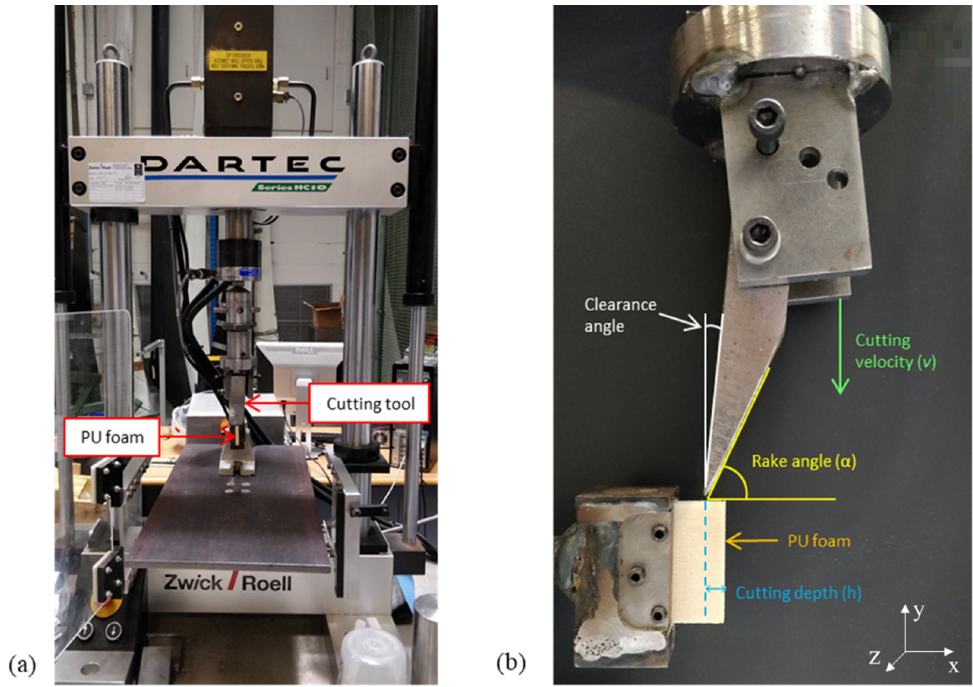
Figure 1. ( a ) Dartec Series HC10 uniaxial testing machine with custom-built orthogonal cutting rig